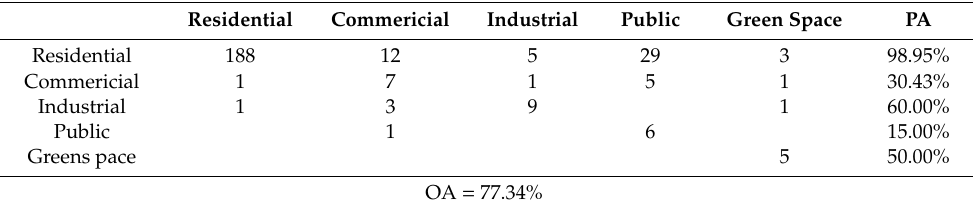
Table 5. Confusion matrix for the test samples without street feature participation.